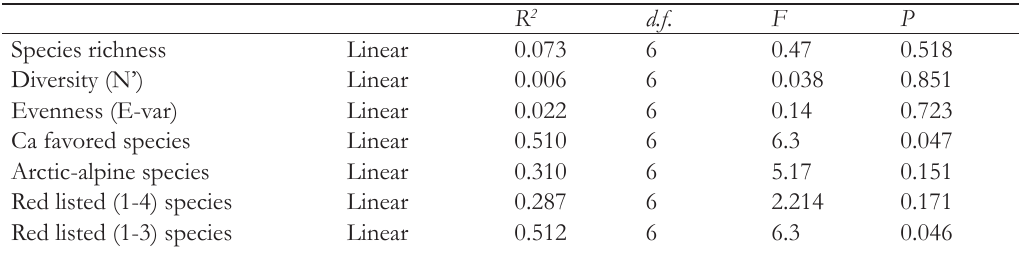
Table 3. Linear and quadratic regressions between the reindeer density index and the various measurements of rich- ness and